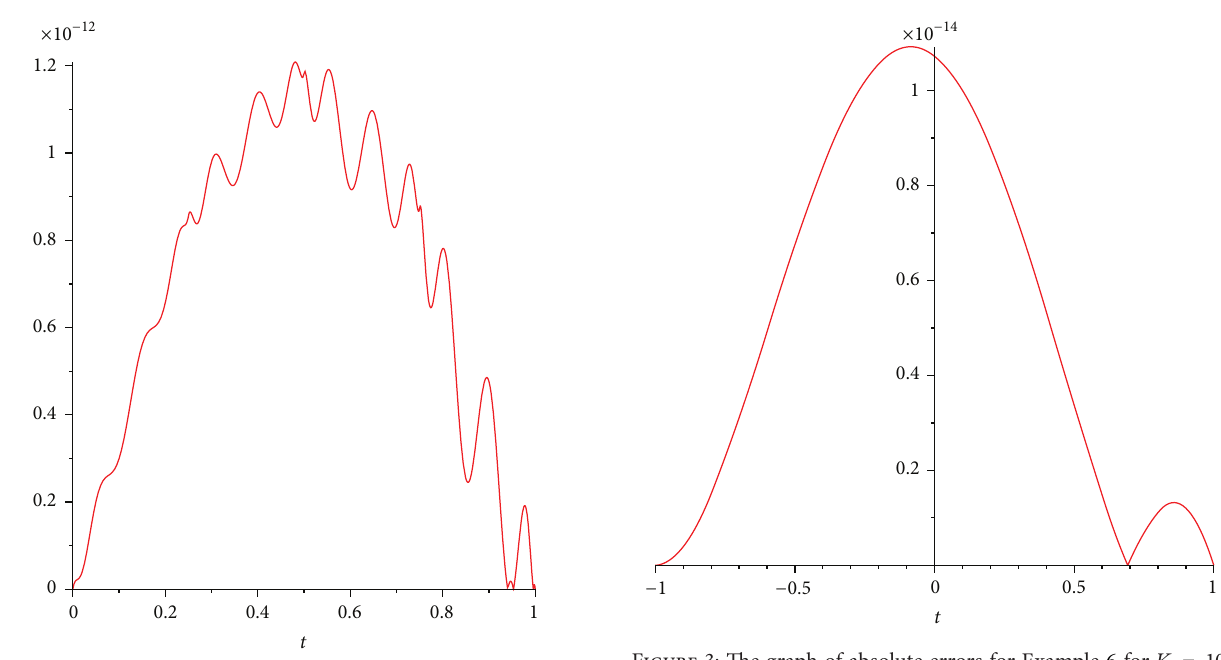
Figure 2: The graph of absolute errors for Example 5 for 𝐾 = 4 , and 𝑀 = 8 .